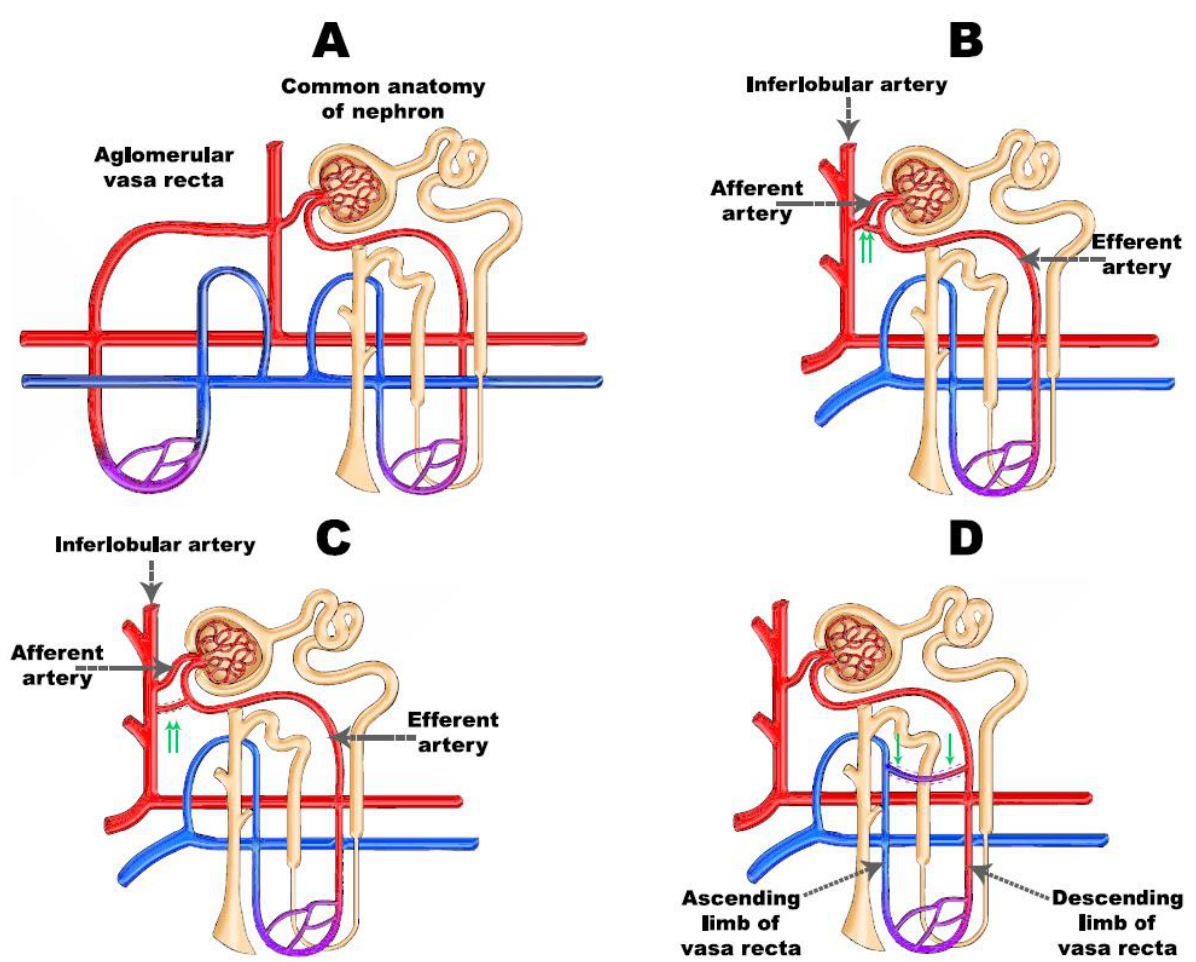
Figure 1. The pre-existing shunts and connections between renal vessels. ( A ) normal anatomy (right) and aglomerular vasa recta (left); ( B ) shunt between afferent and efferent arteries; ( C ) shunt between interlobular artery and vasa recta; ( D ) intra-medullar shunt in the vasa recta system. Red vessels: arteries; blue vessels: veins; purple vessels: connection vessels between arteries and veins; yellow tubes: urine conducting system; green arrows: irregular vessels.